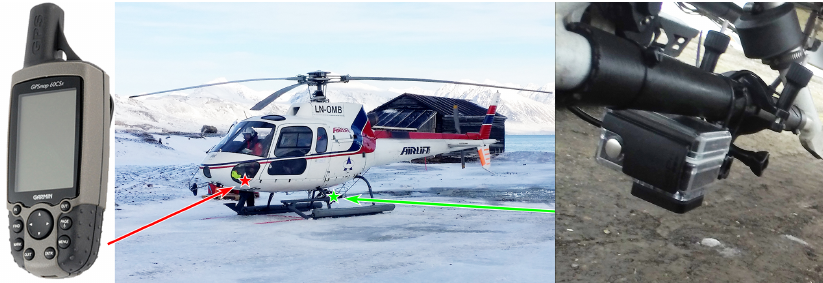
Figure 6. Garmin GPSmap 60CSx, Eurocopter AS350 (picture taken in Ny Ålesund, right before take-off in September 2014), and GoPro H3+BE.